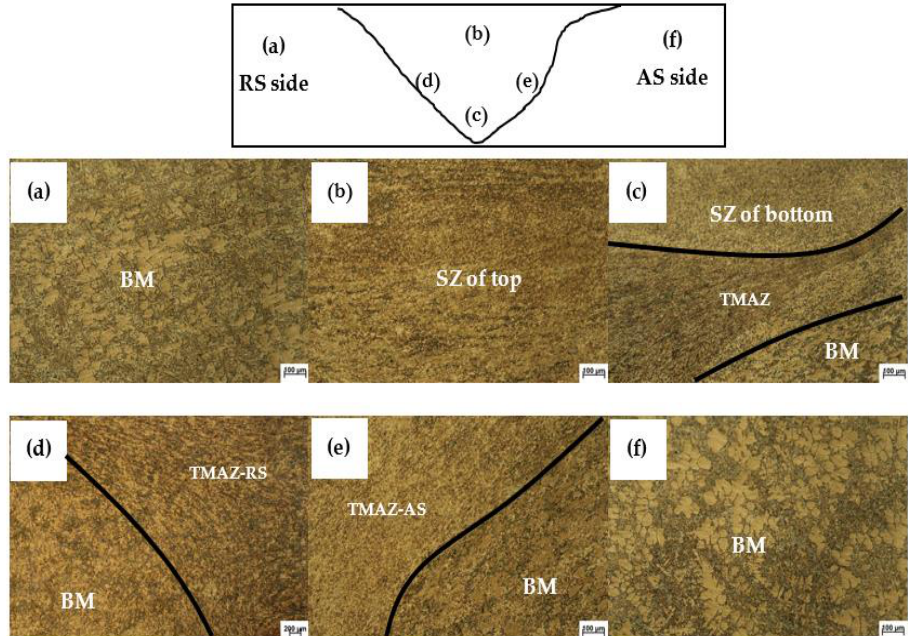
Figure 9. The microstructure photography evaluation by OM of optimal welding conditions of MOVaNSAS: ( a , f ) BM, ( b , c ) SZ, ( e ) TMAZ-AS, and ( d ) TMAZ-RS.